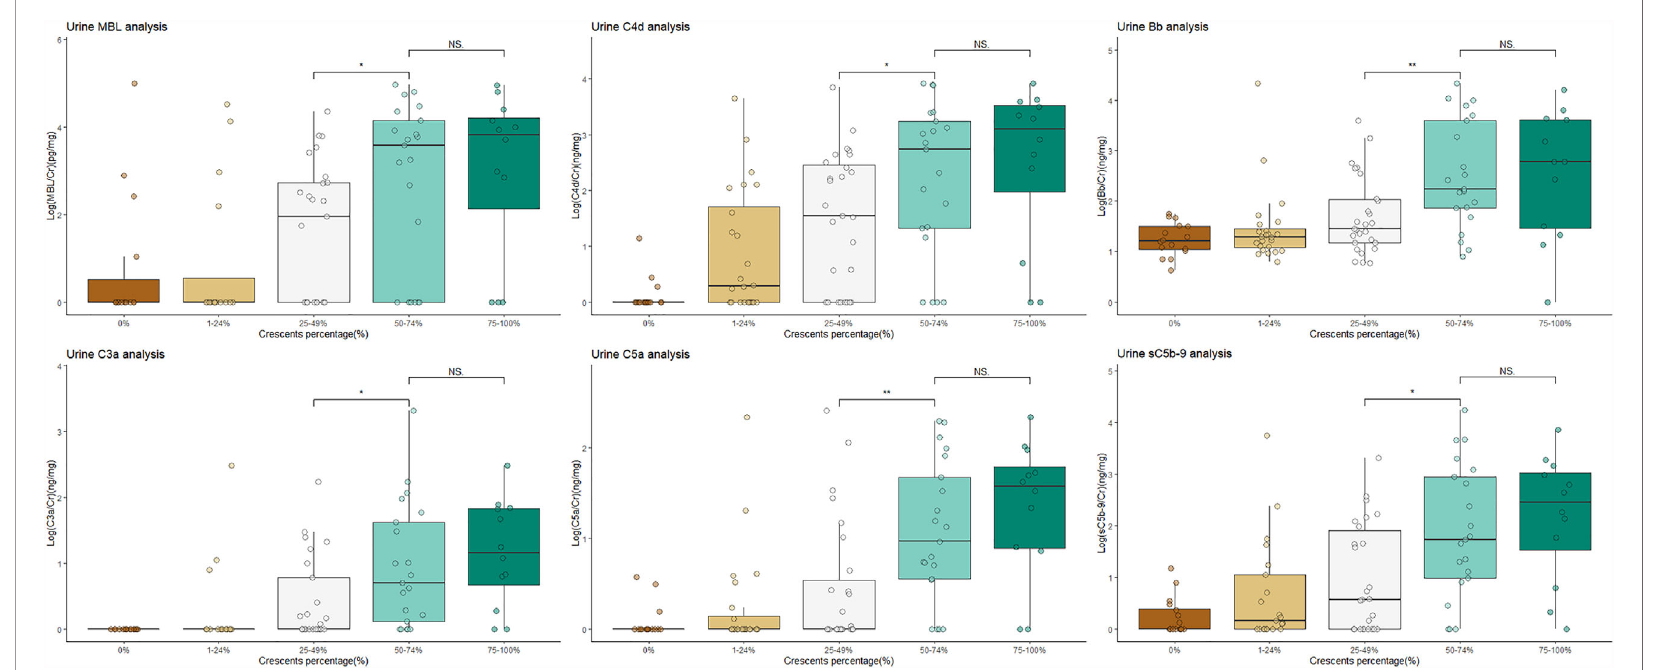
FIGURE 1 | Patients with crescentic IgAN had higher levels of activated complement products in urine than non-crescentic IgAN patients. NS, not signi fi cant; IgAN, IgA nephropathy. The urine values were corrected by urinary creatinine. All the data were